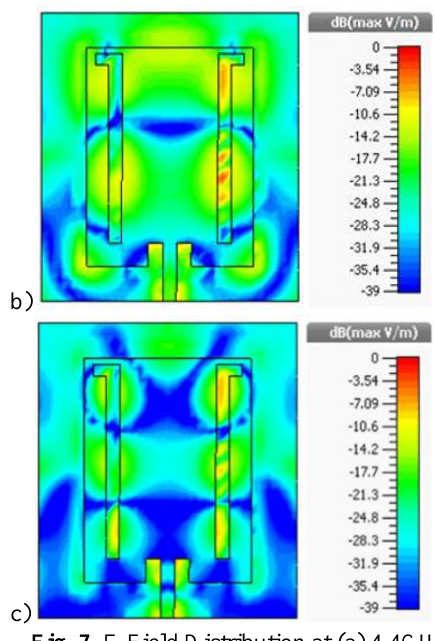
Fig. 7. E-Field Distribution at (a) 4.4GHz, (b) 6.2GHz and (c) 8.5GHz